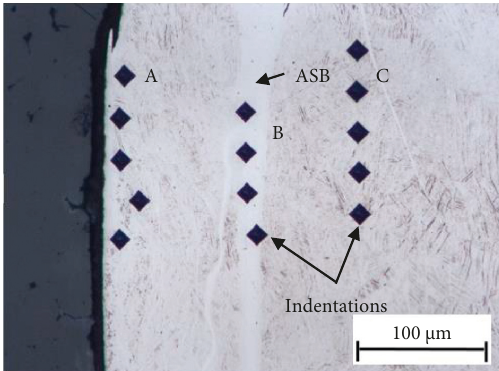
Figure 22: Optical micrograph showing the indentations for the Vickers microhardness testing of a 10mm thick